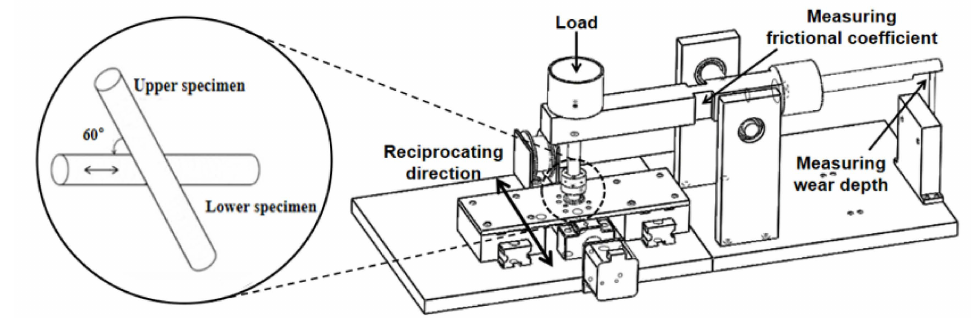
Figure 1. Testing